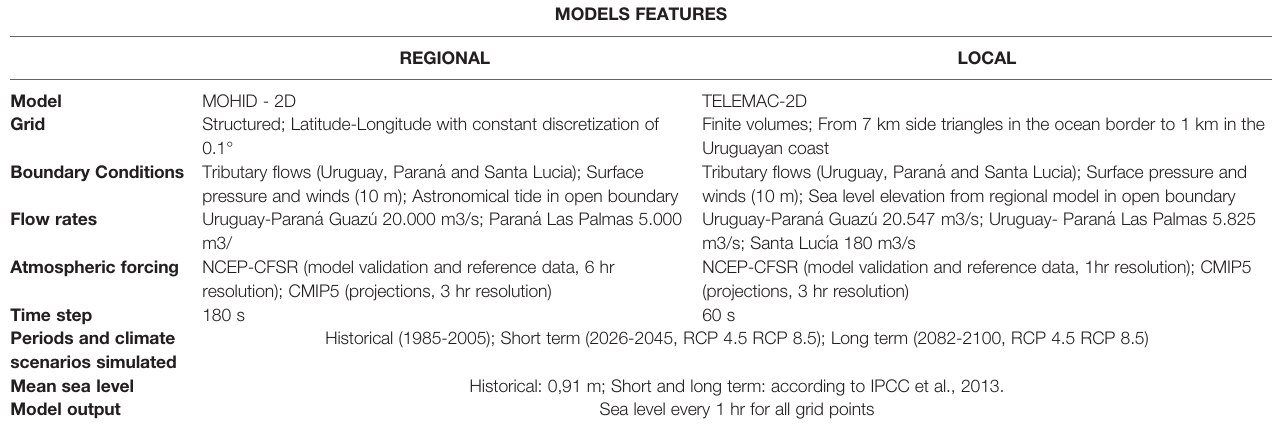
TABLE 1 | Features of the setup for both regional and local hydrodynamic models.